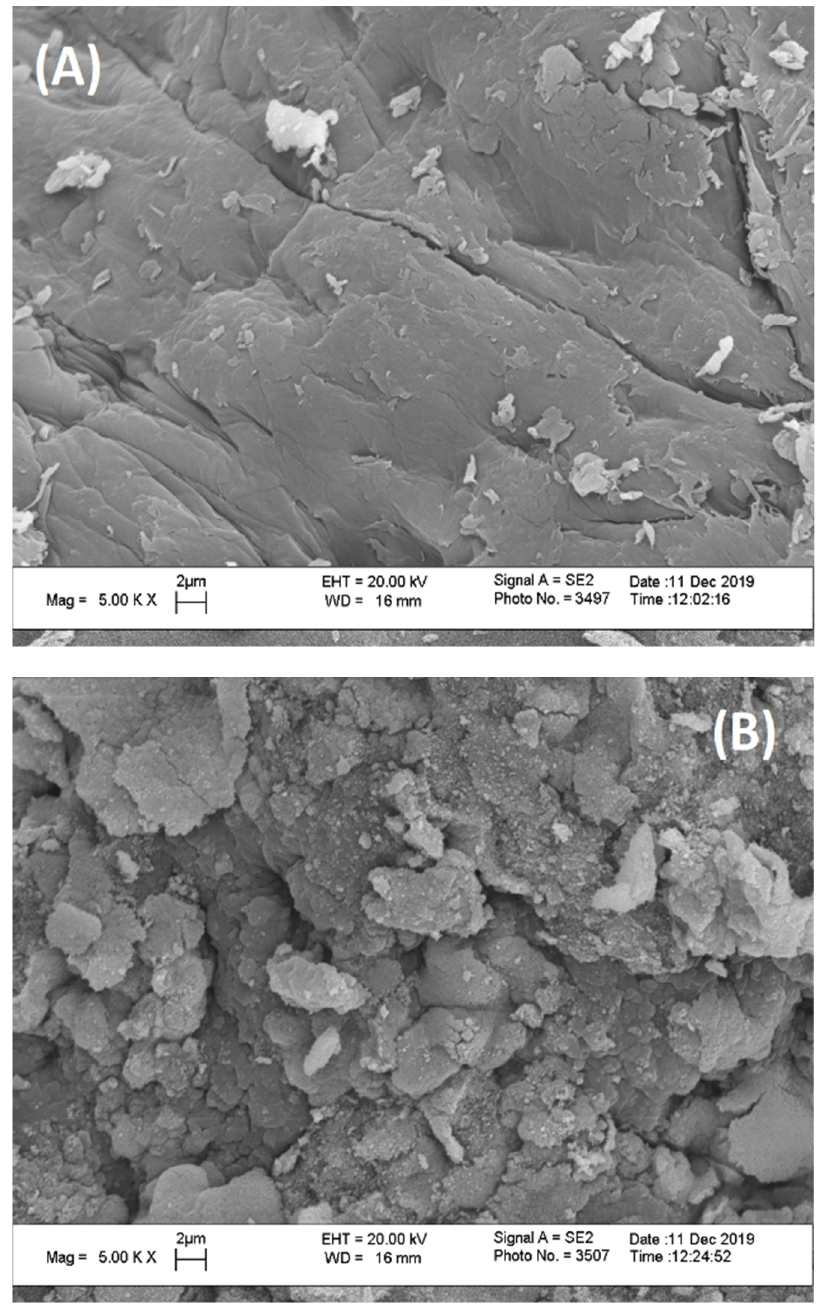
Figure 3. SEM of chitosan ( A ), and chitosan-CuO nanocomposites, (15 wt.%) ( B